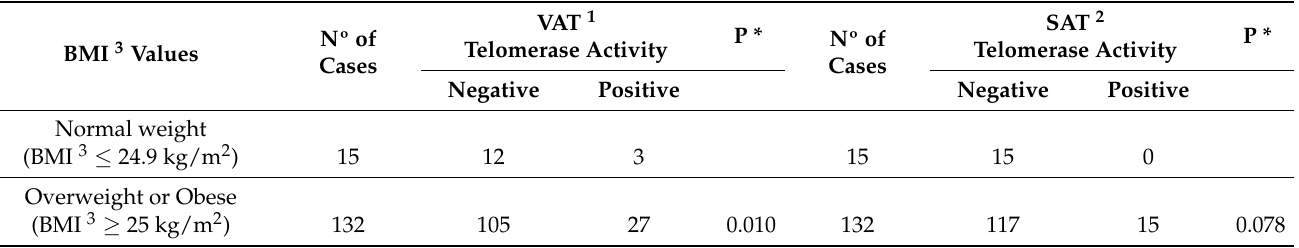
Table 2. Telomerase activity in visceral and subcutaneous adipose tissues in relation to the body mass